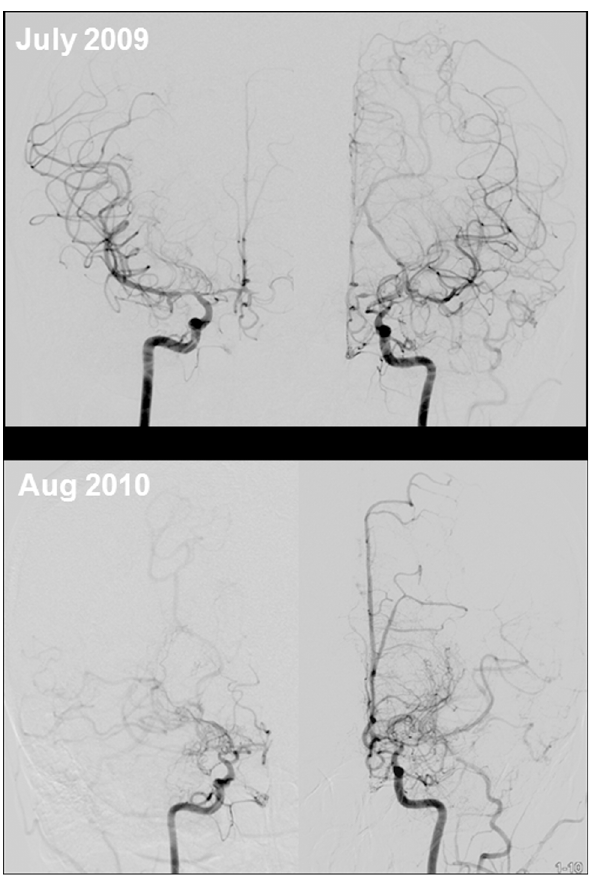
Fig 2. Angiographic progression of MMD in an adult patient with intracranial stenosis. A 42-year-old female presented with transient numbness and clumsiness of her left hand. She had mild stenosis on bilateral and proximal middle cerebral arteries. There was no stenosis of the distal internal carotid artery and basal collaterals, called Moyamoya vessels, on conventional angiography (upper lane). Angiographic findings taken one year later show the progression of stenosis and Moyamoya vessels bilaterally (lower lane). Genetic study revealed RNF213 mutation associated with MMD